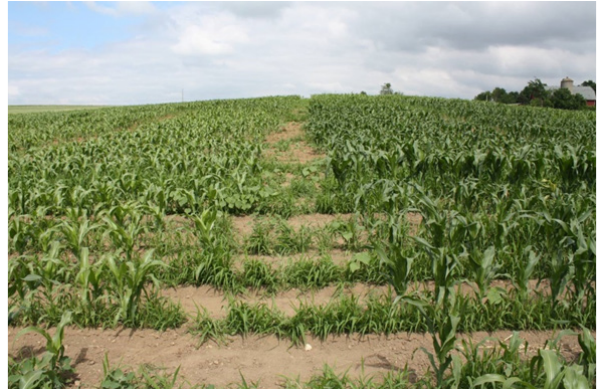
Figure 10: The BC1 S3 breeding lines C4-5, C4-6, and C4-7 grown side by side after clover grass in 2015 on a McHenry silt loam near Elkhorn, WI. Note the ‘N-type’ with dark foliage is the central C4-6